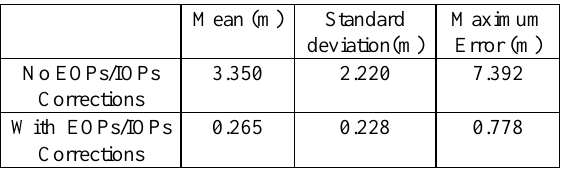
Table 4. Mapping solution accuracies with and without